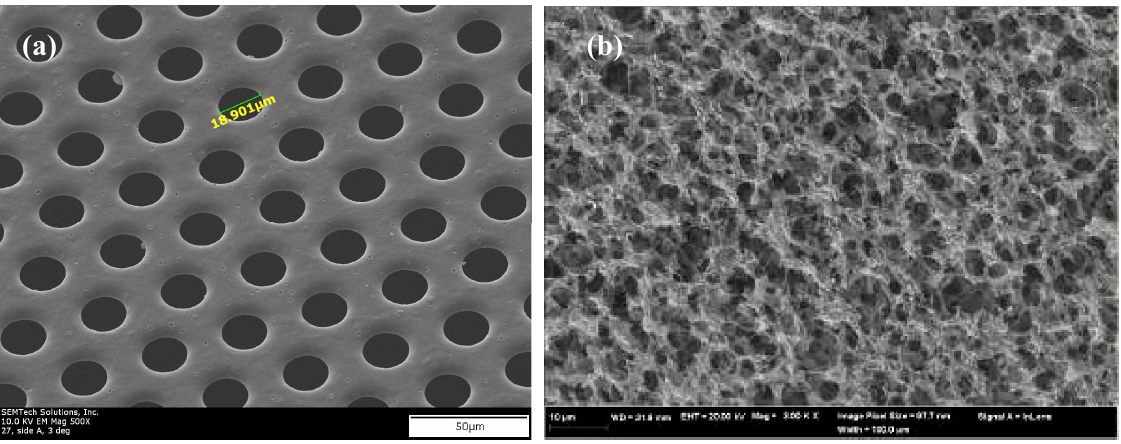
Figure 7. Micrographs of dimensionally stable membranes ( a ) Two-dimensional stable membranes (2DSM); ( b ) three-dimensional stable membranes (3DSM) [38,39].